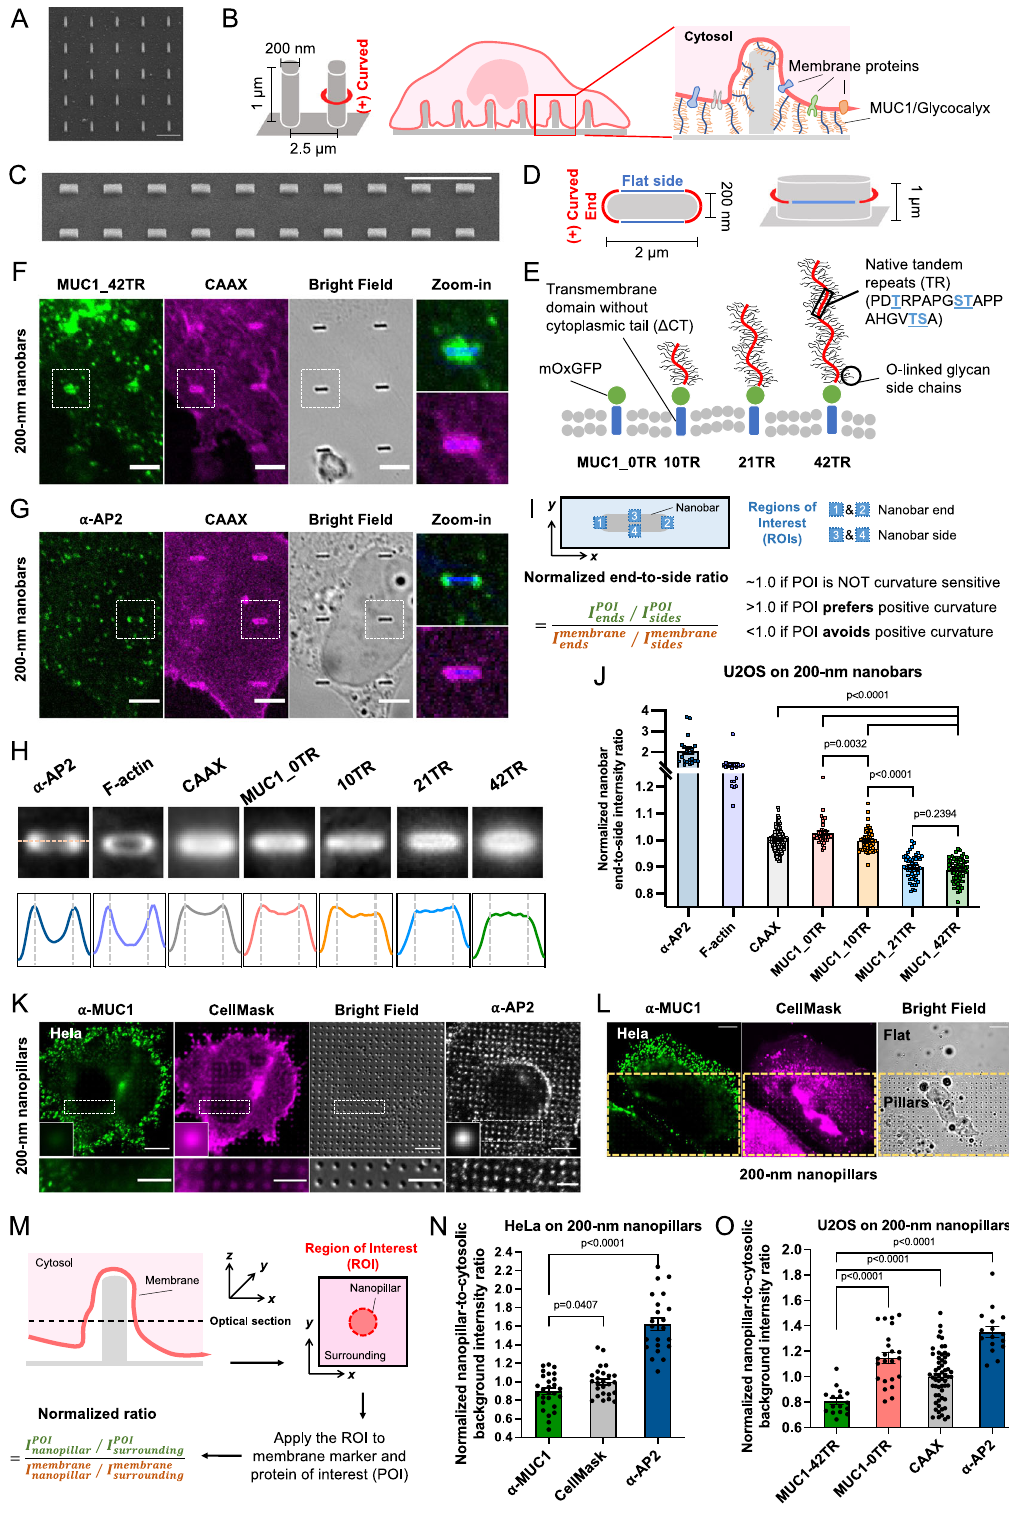
F-actin, two proteins previously demonstrated to prefer positive curvature, strongly accumulate at the ends of nanobars (Fig. 1H). (Fig. 1F – H and Supplementary Fig. 3). We quanti fi ed the nanobar end-to-side ratio for each protein in individual cells and then normalized the ratios to the average value of